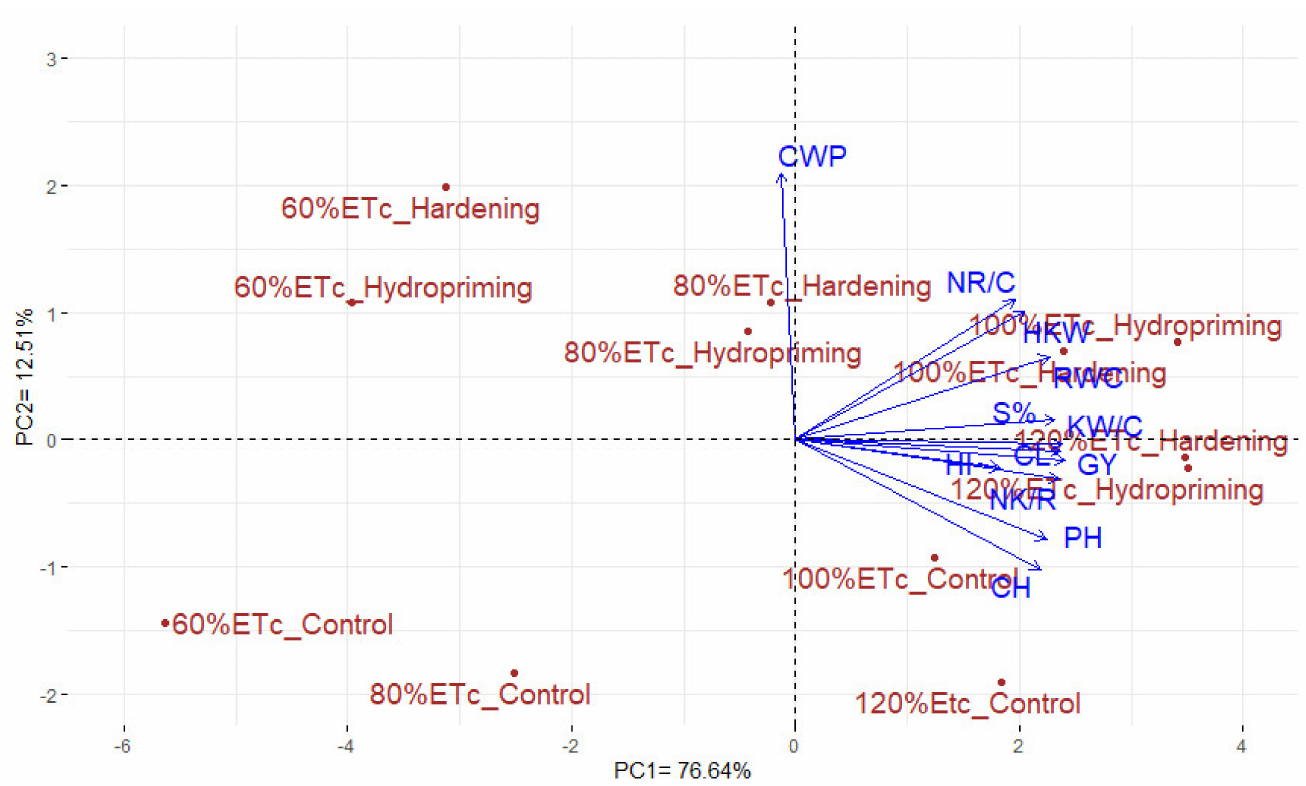
Figure 5. Biplot of principal components for studied traits of maize grown under four irrigation regimes and three seed priming treatments over two growing seasons (2019 and 2020). RWC is relative water content, PH is plant height, CH is cob height, CL is cob length, NR/C is number of rows per cob, NK/R is number of kernels per row, KW/C is kernel weight per cob, S% is shelling percentage, HKW is 100-kernel weight, GY is grain yield, HI is harvest index and CWP is crop water